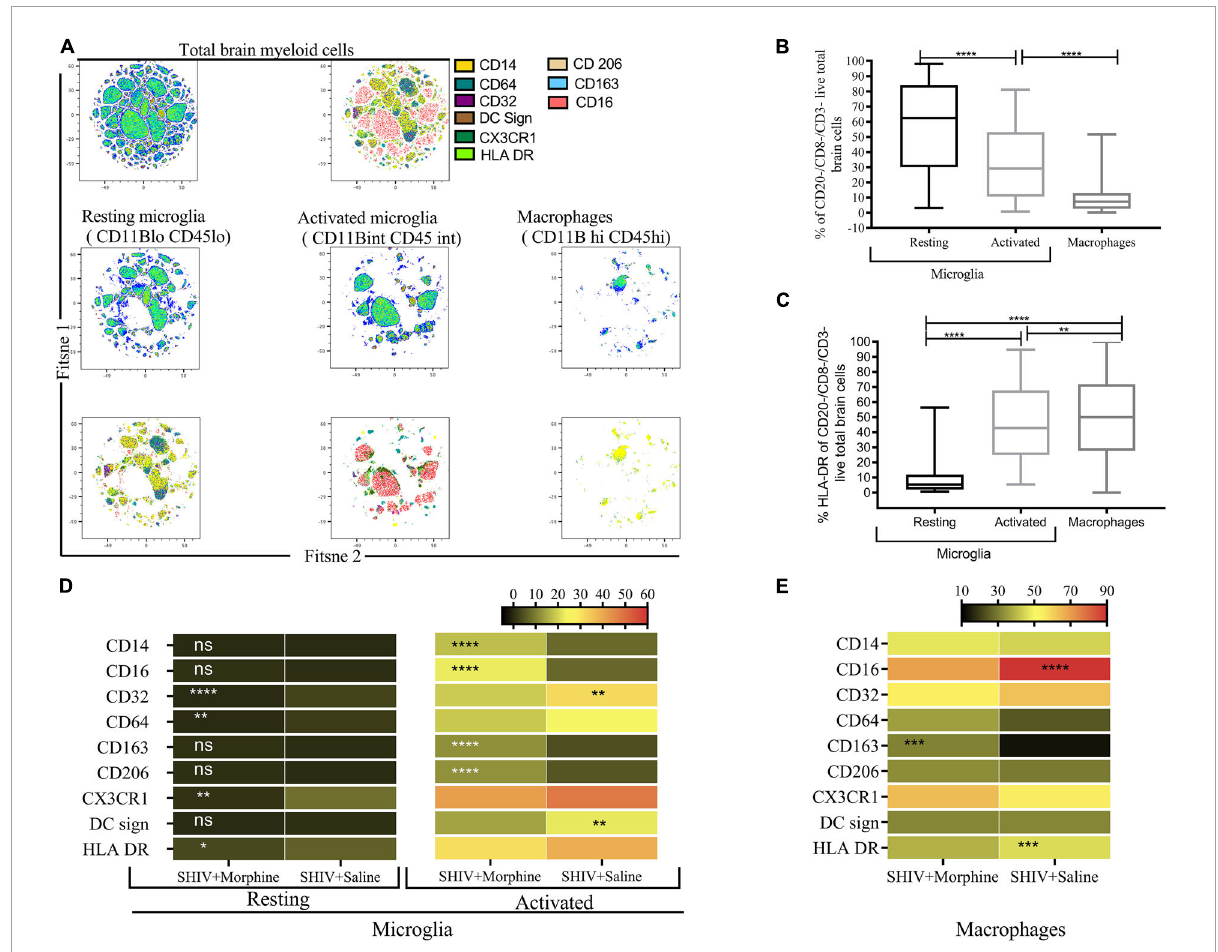
FIGURE2 Flow Cytometric surface marker analysis reveals divergent brain myeloid phenotypes in SIV infected macaques exposed to either morphine or saline. (A) FitSNE projection of different macrophage/microglia phenotype markers expressed on total brain myeloid cells pooled from different brain regions in simian human immunodeficiency virus (SHIV) infected macaques ( n = 8) exposed to either morphine or saline. (B) Percent frequencies of resting microglia, activated microglia and macrophages within total myeloid cells pooled from different brain regions as denoted by CD45 and CD11B discrimination. Data represent median ± range. (C) Evaluation of the extent of HLA-DR expression within resting microglia, activated microglia and macrophages pooled from diverse brain regions. Representative data denote median ± range. (D) Comparisons of % frequencies of CD14, CD16, CD32, CD64, CD163, CD206, CX3CR1, DC Sign, and HLA-DR in resting/activated microglia (E) macrophages in SHIV infected macaques treated with either morphine or saline. [* p < 0.05, ** p < 0.01, *** p < 0.001, **** p < 0.0001 using the Wilcoxon test for paired non-parametric differences within groups (B,C) ]. Mann–Whitney U -tests used for panels (D,E) .